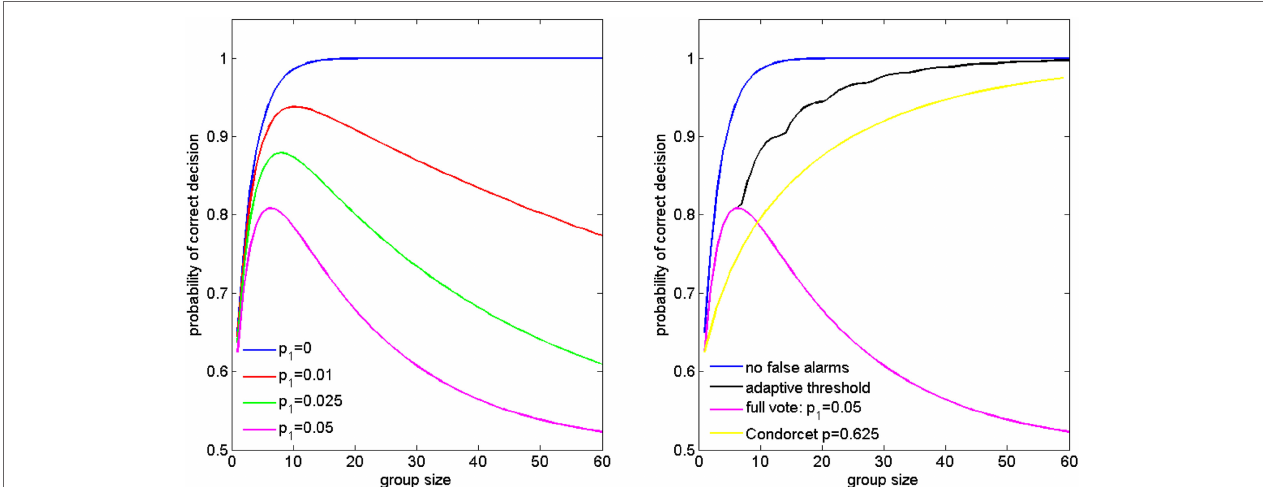
FIGURE A1 | The effect of false alarms. Left panel: The effect of varying false alarm probability p 1 on performance of the full vote method ( p 2 was fixed at 0.3 for all curves on the panel). Right panel: performance can be restored if we allow the decision threshold T to vary as group size N changes. Black curve demonstrates how even with false alarm probability p 1 = 0.05, we can rescue performance if we choose the optimal T for each N . The yellow curve gives the performance of the group if all members were statistically independent (Condorcet) so as to show that small false alarm probabilities do not disrupt the ability to make gains as compared to the independent agent